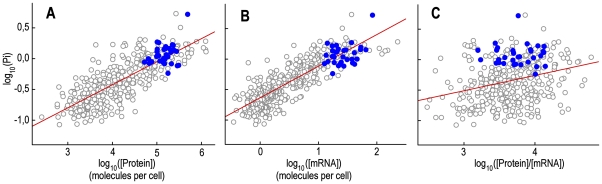
Pi versus gene expression levels in S. cerevisiae.Scatter plots of Pi versus cellular protein concentration (panel A), cellular mRNA concentration (panel B) and protein per mRNA molecule (panel C). All values are log-transformed. Blue circles represent genes belonging to the ontology category “structural constituent of the ribosome”.